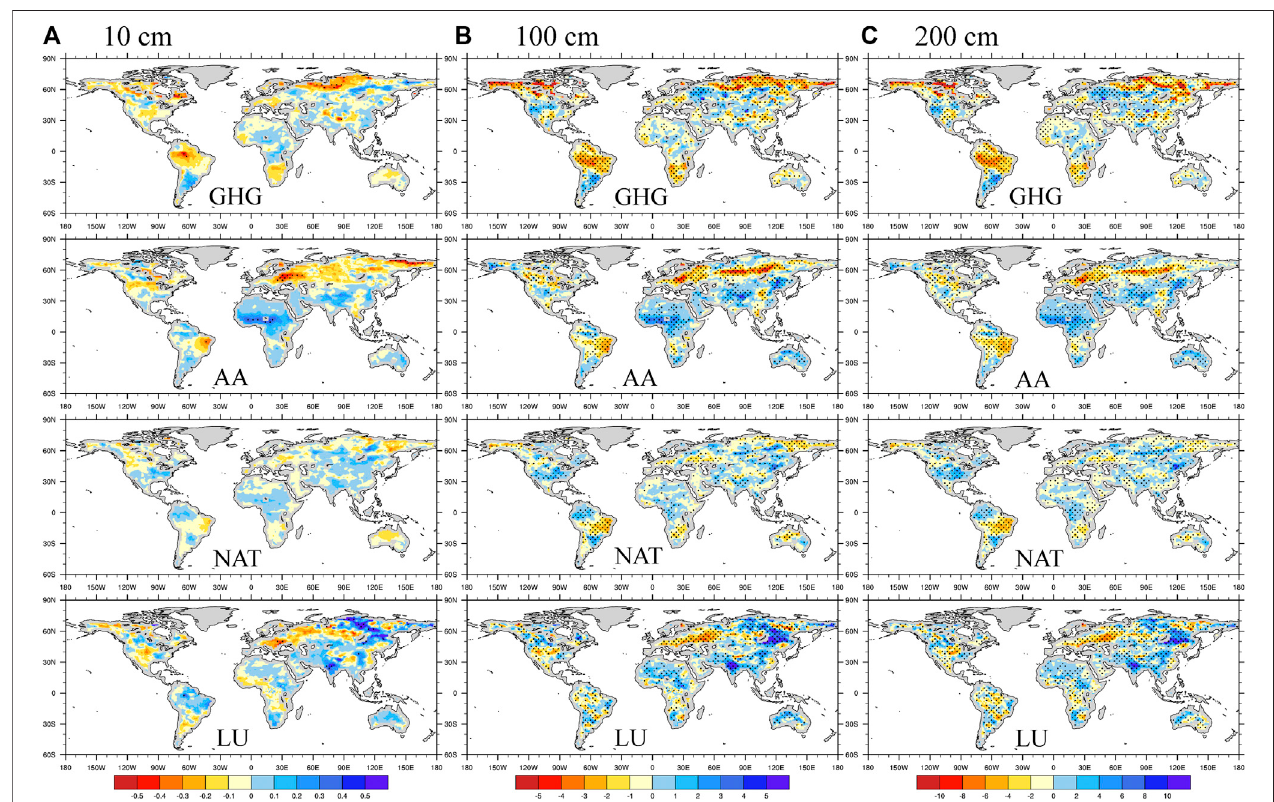
FIGURE 4 | Spatial distribution of the soil moisture trend (kg/m 2 /decade, 1979 – 2014) from CMIP6 experiments (the experiment only considering greenhouse gases (GHG) forcing, the experiment only considering anthropogenic aerosols (AA) forcing, the experiment only considering natural (NAT) forcing, and the experiment only considering land use (LU) forcing). (A) , (B) , and (C) Shallow (10 cm), middle (100 cm), and deep (200 cm) soil moisture, respectively. Black dots indicate where a given area passes the 90% signi fi cance